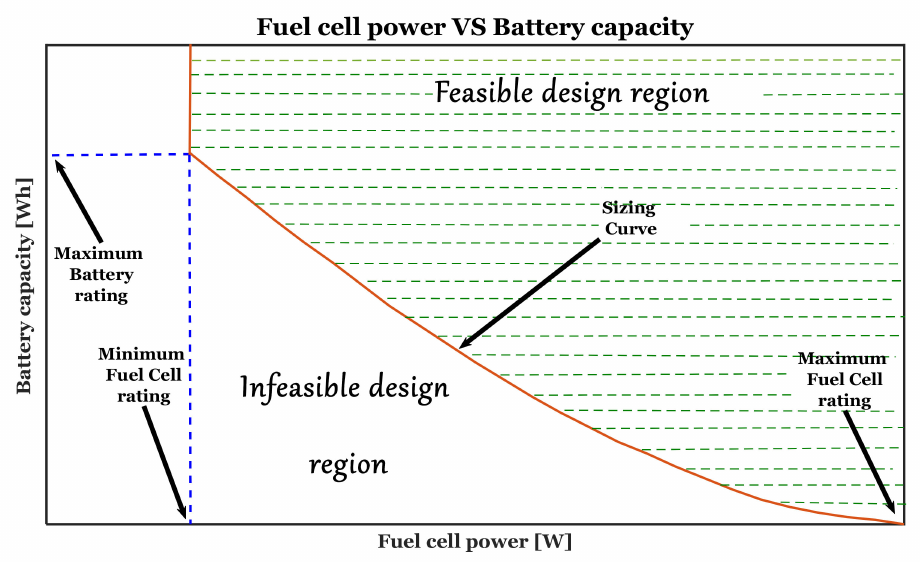
Figure 6. Typical sizing Pareto